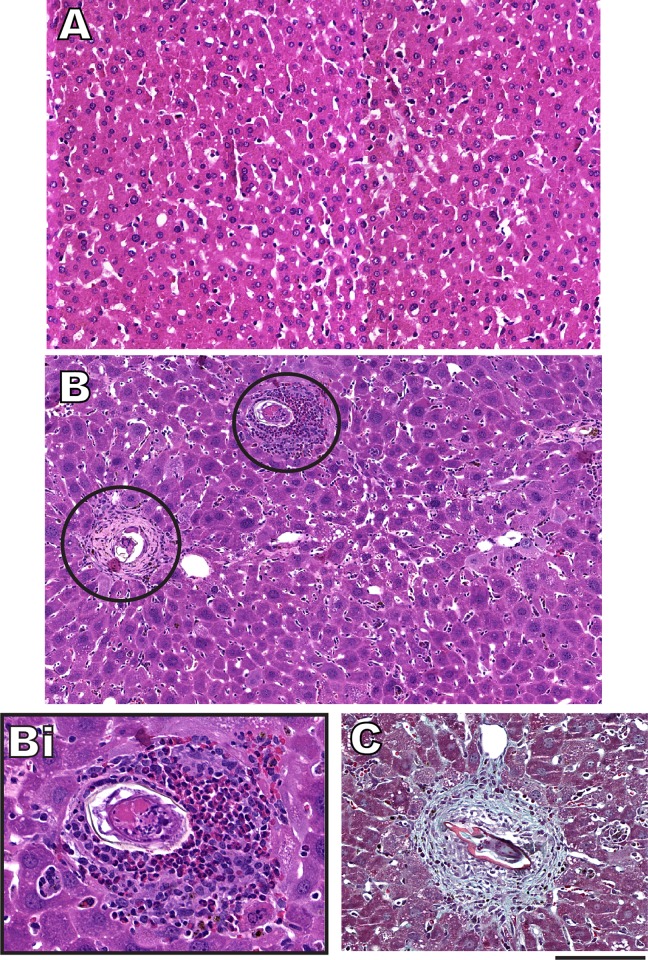
Representative histological images of the liver from uninfected (A) and naturally S. mansoni-infected N. squamipes (B). A normal hepatic tissue is seen in (A) while typical granulomas at different developmental stages (circles) are observed in (B). One mature granuloma characterized by a central parasite egg surrounded by a dense population of inflammatory cells is shown in high magnification in (Bi). Eosinophils with characteristic acidophilic cytoplasm and mononuclear cells are clearly observed. In (C), the layer formed by collagen fibers is seen at the outer zone of the granuloma. Liver fragments (n = 3 animals from each group) were fixed in buffered paraformaldehyde, embedded in glycolmethacrylate resin and cut into 3 μm-thick sections, which were stained with hematoxylin-eosin (A, B) or Gomori’s trichrome (C). Scale bar, 60 μm (A, B); 120 μm (Bi); 100 μm (C).